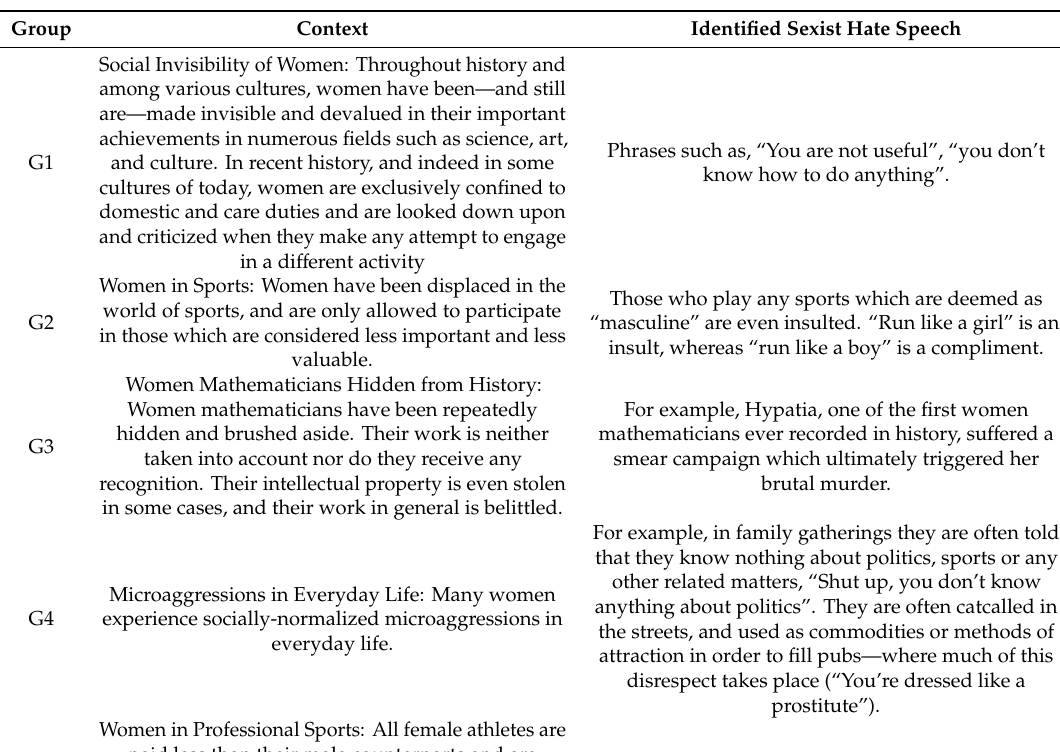
Table 2. Group, context, and identified sexist hate